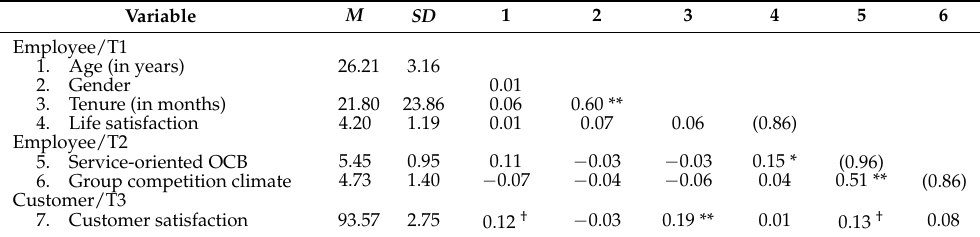
Table 1. Means, Standard Deviations, Pearson Correlations, and Scale Reliabilities.